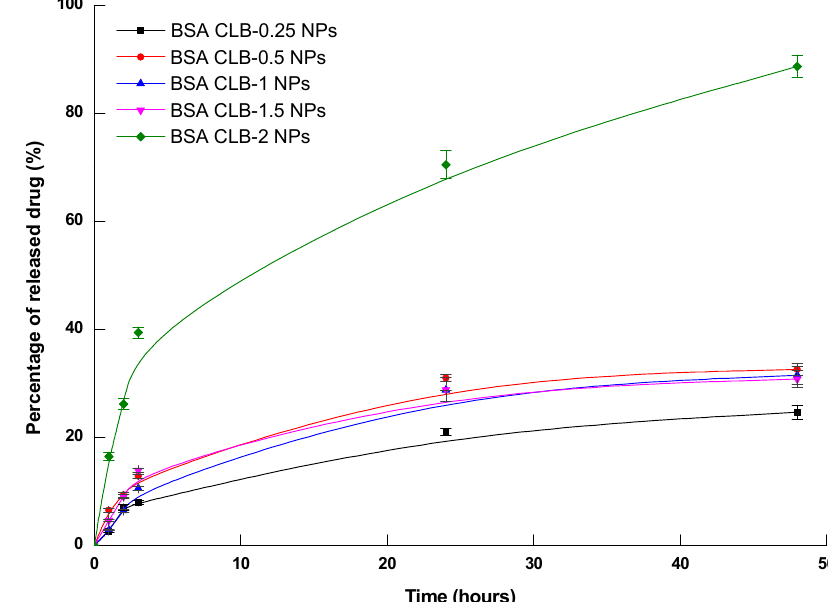
Figure 1. CLB release from BSA nanoparticles ( n = 3 ± average RSD—relative standard deviation).